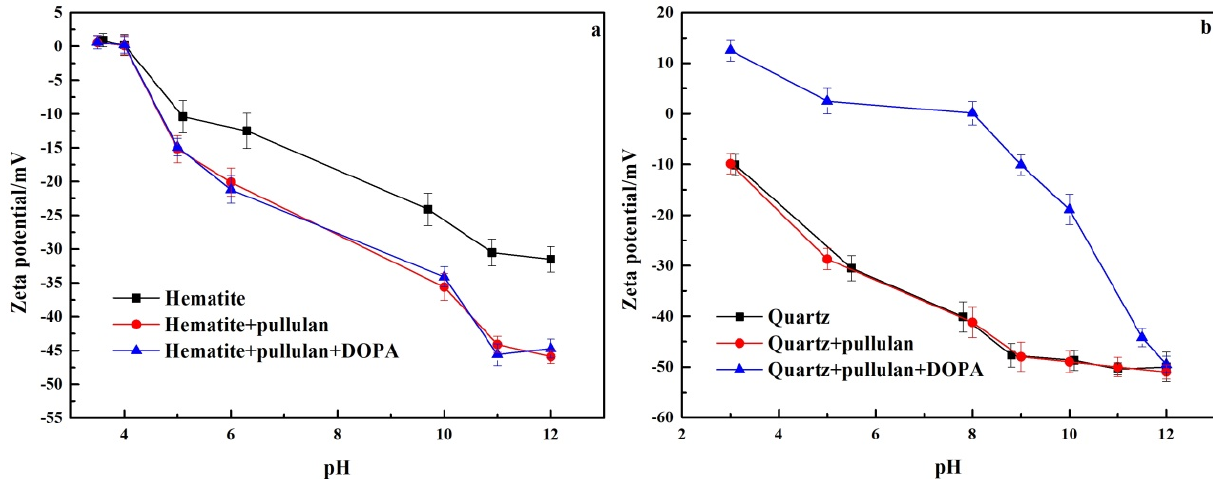
Figure 8. The zeta potential of hematite ( a ) and quartz ( b ).